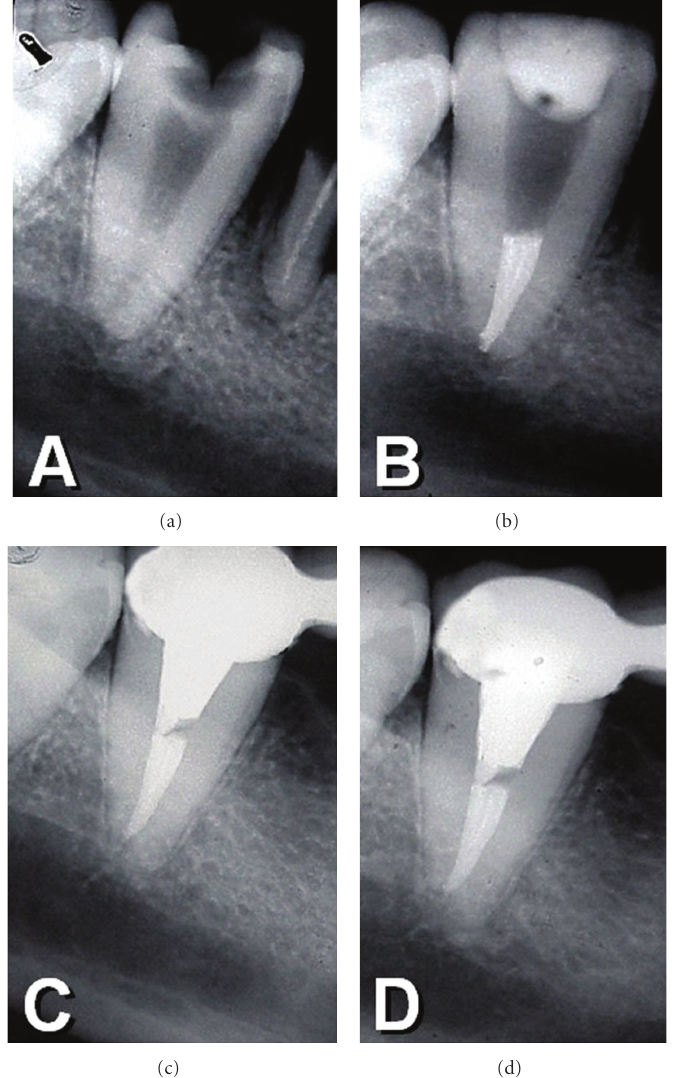
Figure 2: (a) Preoperative radiograph of a mandibular right second molar with deep caries lesion. (b) Immediate postoperative radiograph. Note the root canal filling was partially removed in order to accommodate a post. (c) and (d) 8- and 10-year recall radiographs showing normal periapical